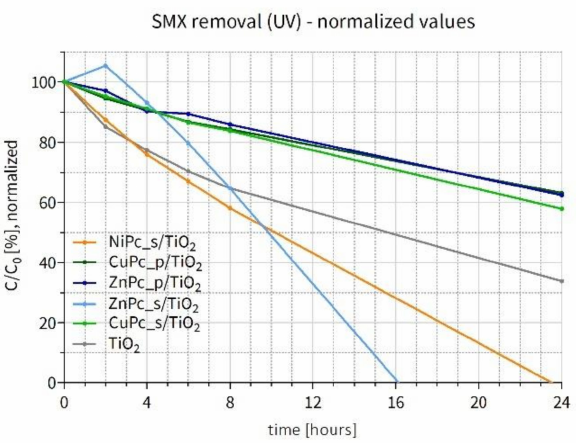
Figure 15. Changes in sulfamethoxazole concentration after UV irradiation (365 nm light) of the water suspension containing a photocatalyst–normalized